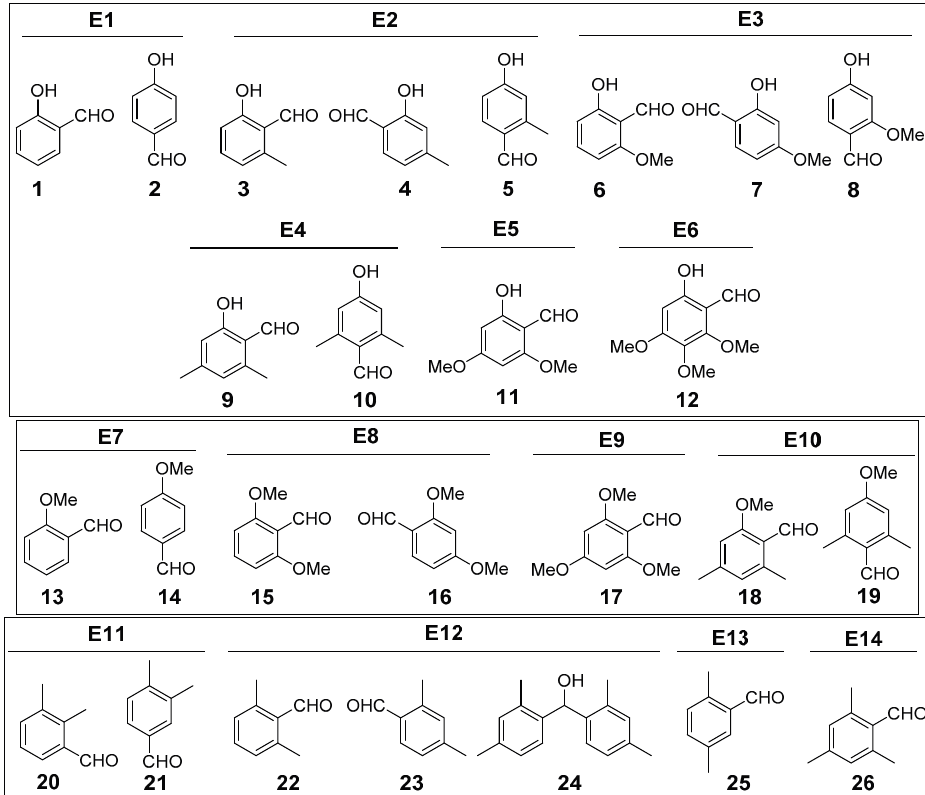
Figure 1. Obtained